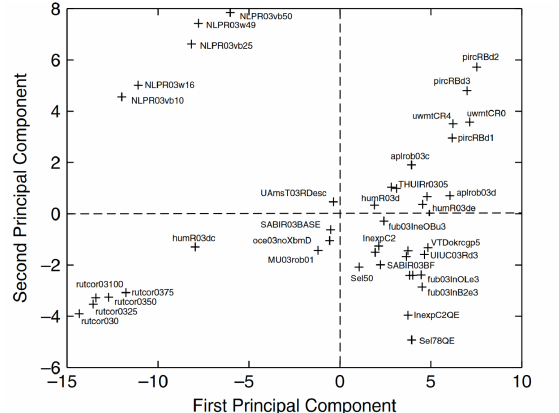
Figure 9. System failure and effectiveness depend on queries—not all systems succeed or fail on the same queries. The visualisation shows the two first principal components of a Principal Component Analysis, where the data of the system effectiveness is obtained for each topic by each participants’ run. MAP measure of TREC 12 Robust Track participants’ runs. Figure reprinted with permission from [10], Copyright 2007, John Wiley and